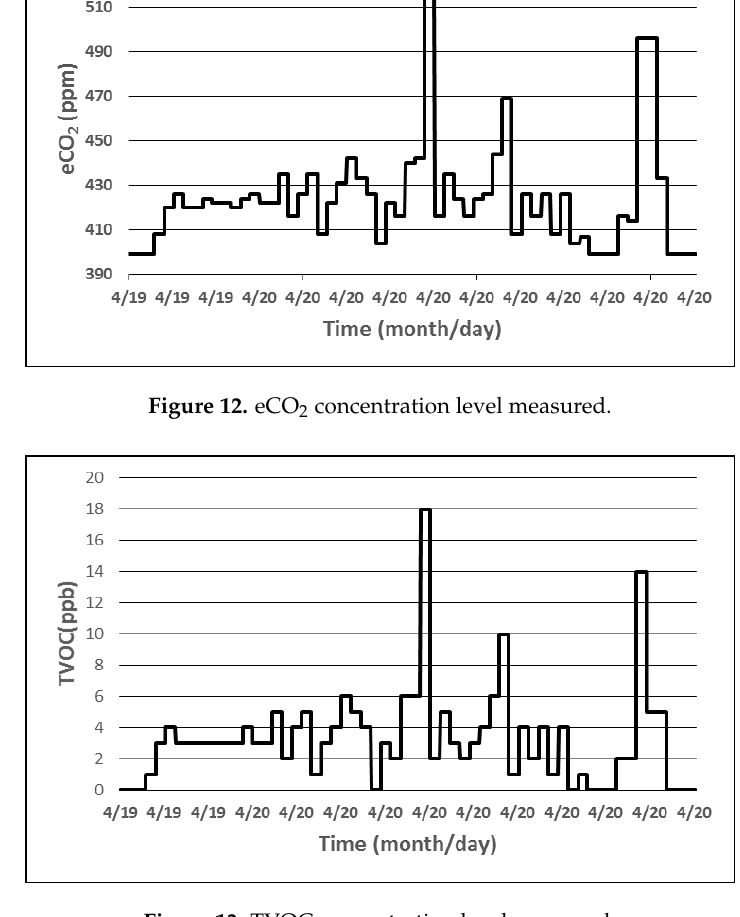
Figure 13. TVOC concentration level